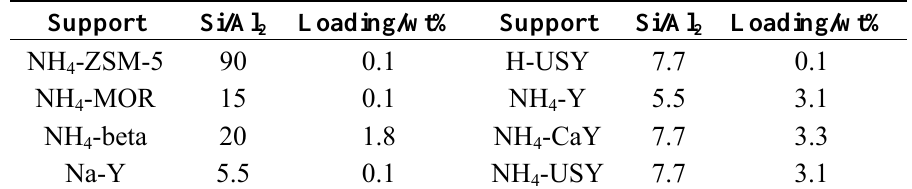
Table 1. Si/Al ratio and Au loading of 2